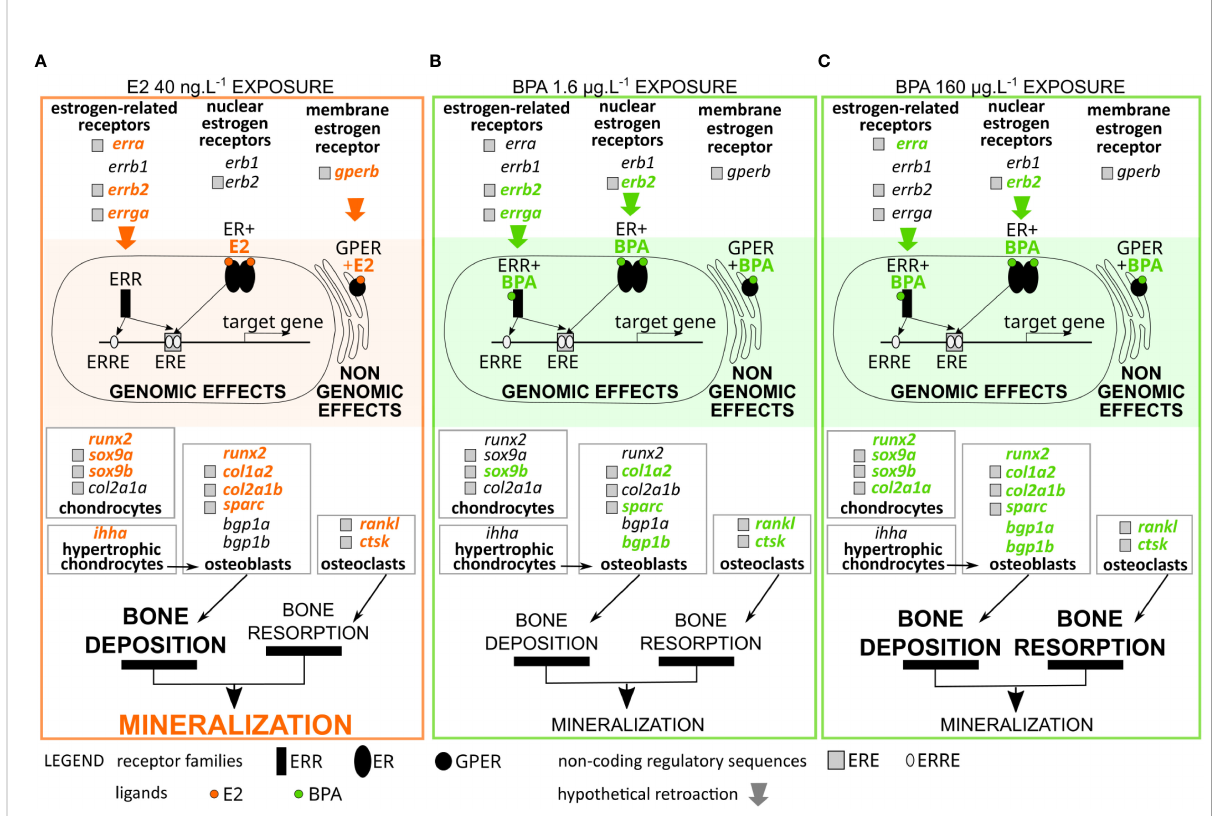
FIGURE 6 Transcriptional and physiological effects of E2 exposure (orange color, (A) 40 ng.L -1 ), and BPA exposure (green color, (B) 1.6 µg.L -1 , (C) 160 µg.L - 1 ). Bold and colored gene names in each panel represent transcriptional upregulation in this condition. Grey squares with gene names represent the putative presence of ERE. Colored arrows represent putative retroaction of the exposure on the signaling pathway, on either its genomic or non-genomic aspects. Bone deposition and resorption, and mineralization, are sized following according to the putative effects of each exposure onto these physiological processes (see discussion for